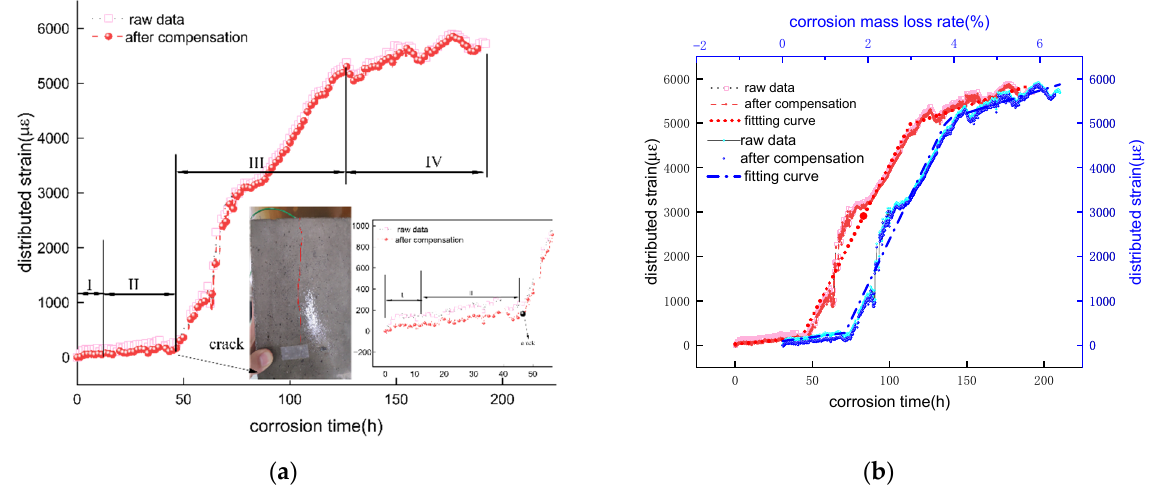
Figure 11. Fiber strain—time curve in mortar layer of 2-150# specimen. ( a ) raw data from reinforced layer distributed sensor; ( b ) fitting curve after temperature compensation. Table 2. Test parameters for significance of fitting curve (red curve) of Figure 11b.